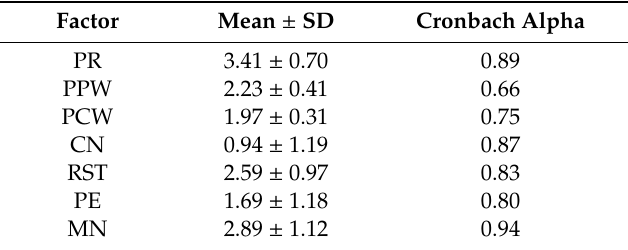
Table 2. Cronbach Alpha of factors of the